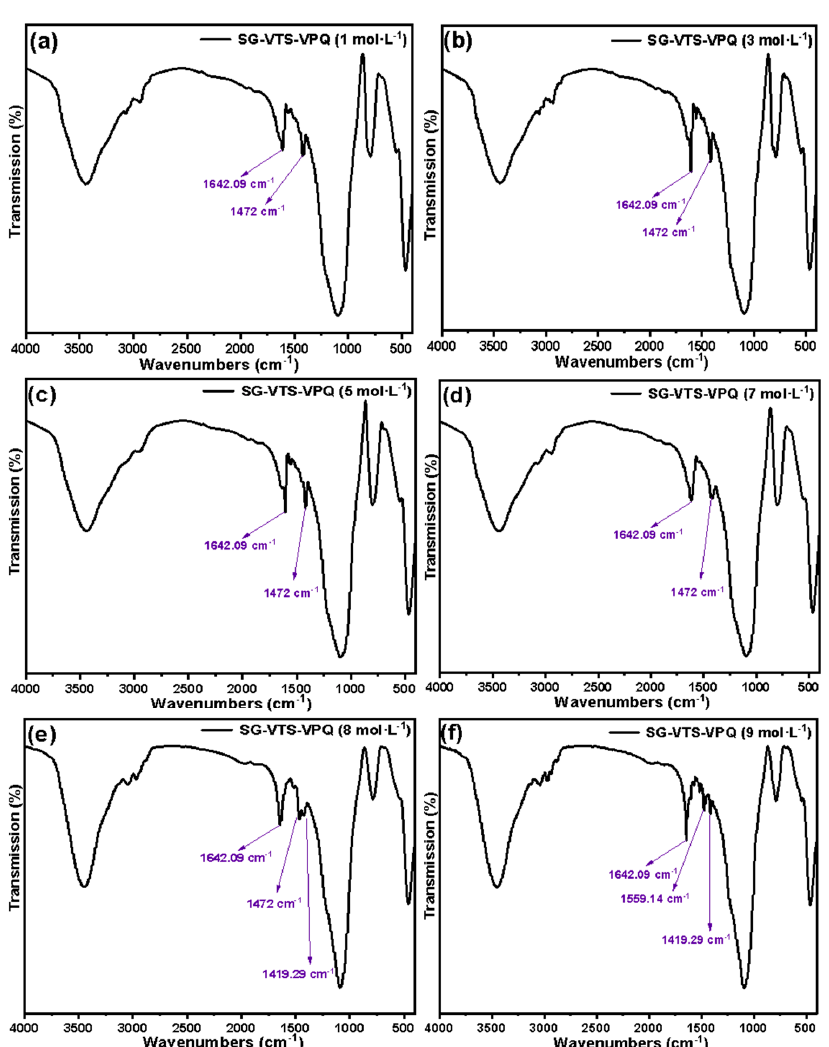
Figure 23. Infrared spectra of SG-VTS-VPQ treated with different concentrations of HNO 3 . ( a ) FTIR of SG-VTS-VPQ treated with 1 mol · L − 1 HNO 3 ; ( b ) FTIR of SG-VTS-VPQ treated with 3 mol · L − 1 HNO 3 ; ( c ) FTIR of SG-VTS-VPQ treated with 5 mol · L − 1 HNO 3 ; ( d ) FTIR of SG-VTS-VPQ treated with 7 mol · L − 1 HNO 3 ; ( e ) FTIR of SG-VTS-VPQ treated with 8 mol · L − 1 HNO 3 ; ( f ) FTIR of SG-VTS-VPQ treated with 9 mol · L − 1 HNO 3 .